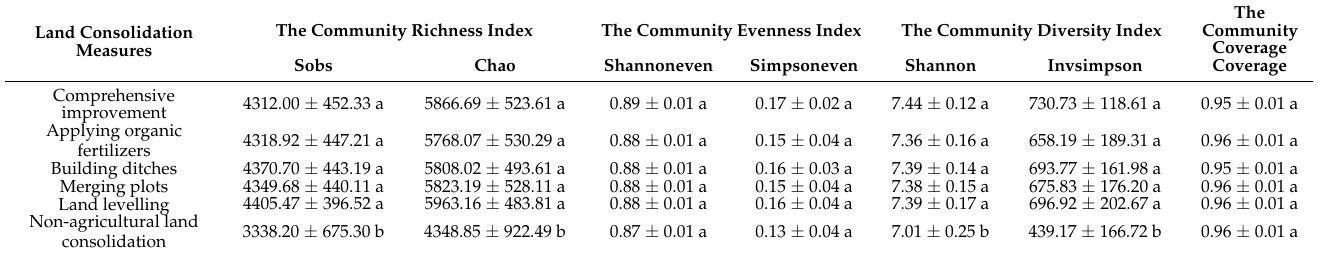
Table 2. Table of soil fungal diversity indicators under different farmland consolidation.